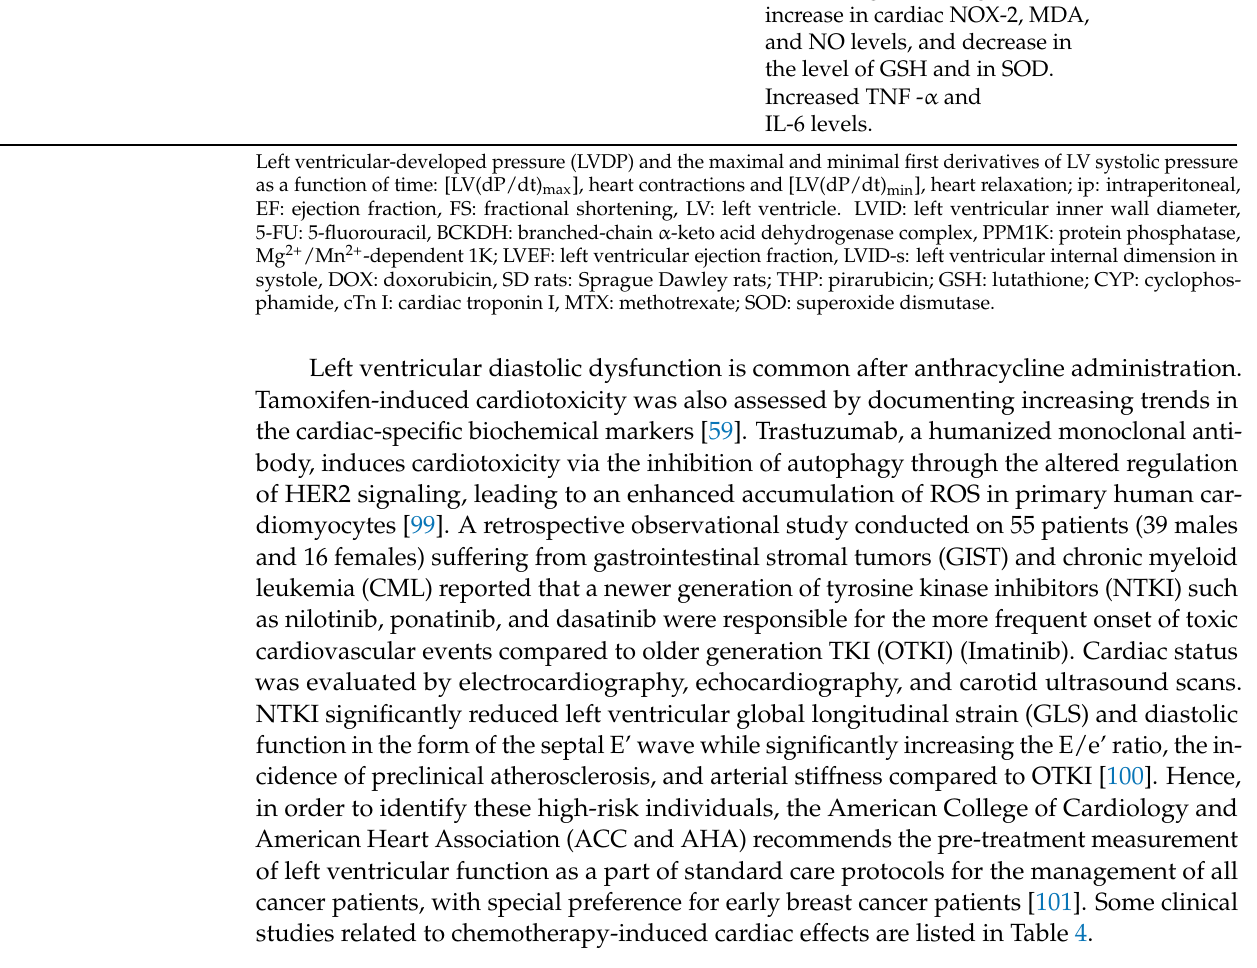
Table 4. Clinical studies revealing chemotherapy-induced cardiovascular adverse